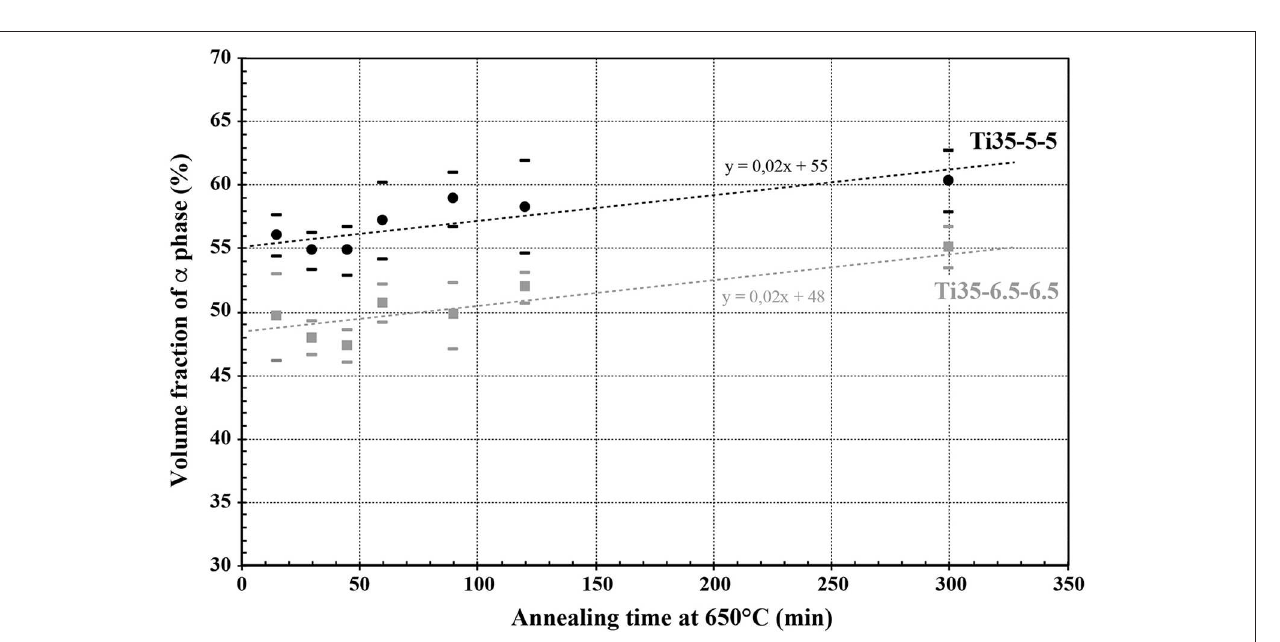
microstructure is confirmed for both Ti35-5-5 and